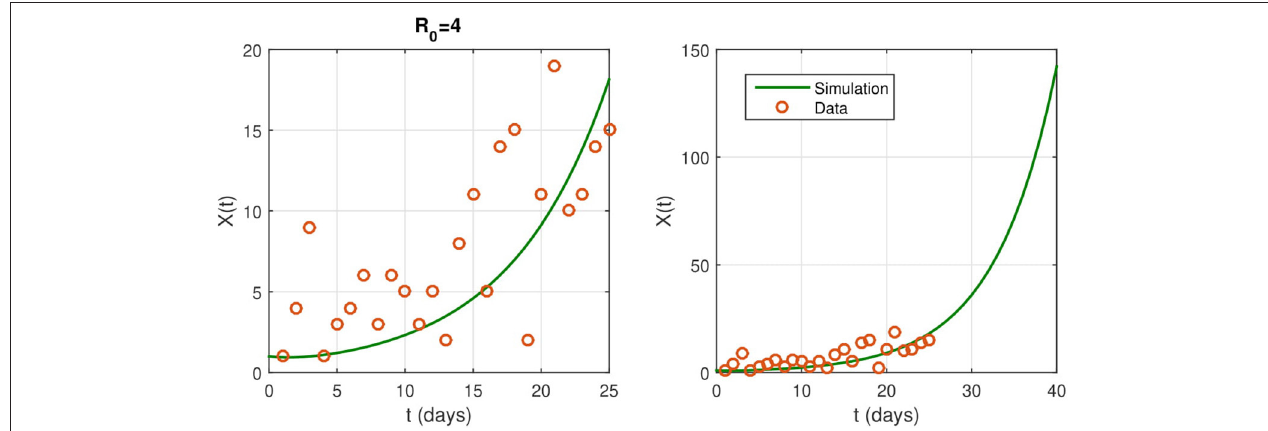
FIGURE 2 | (Left) The fitted curve for epidemic evolution, with ε = 0.08. The small red circles are the reported case data. (Right) an illustrations of the shape of X ( t ) without any intervention. It predicts the spread of the epidemic.